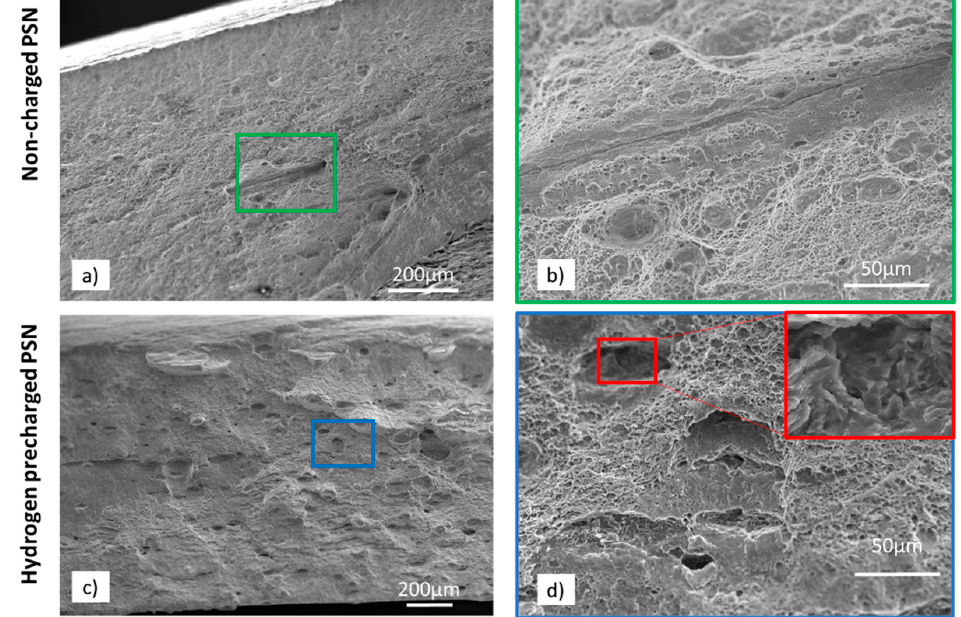
Figure 12. SEM fracture surface of non-charged PSN specimen ( a , b ) and hydrogen-charged PSN specimen ( c , d ).